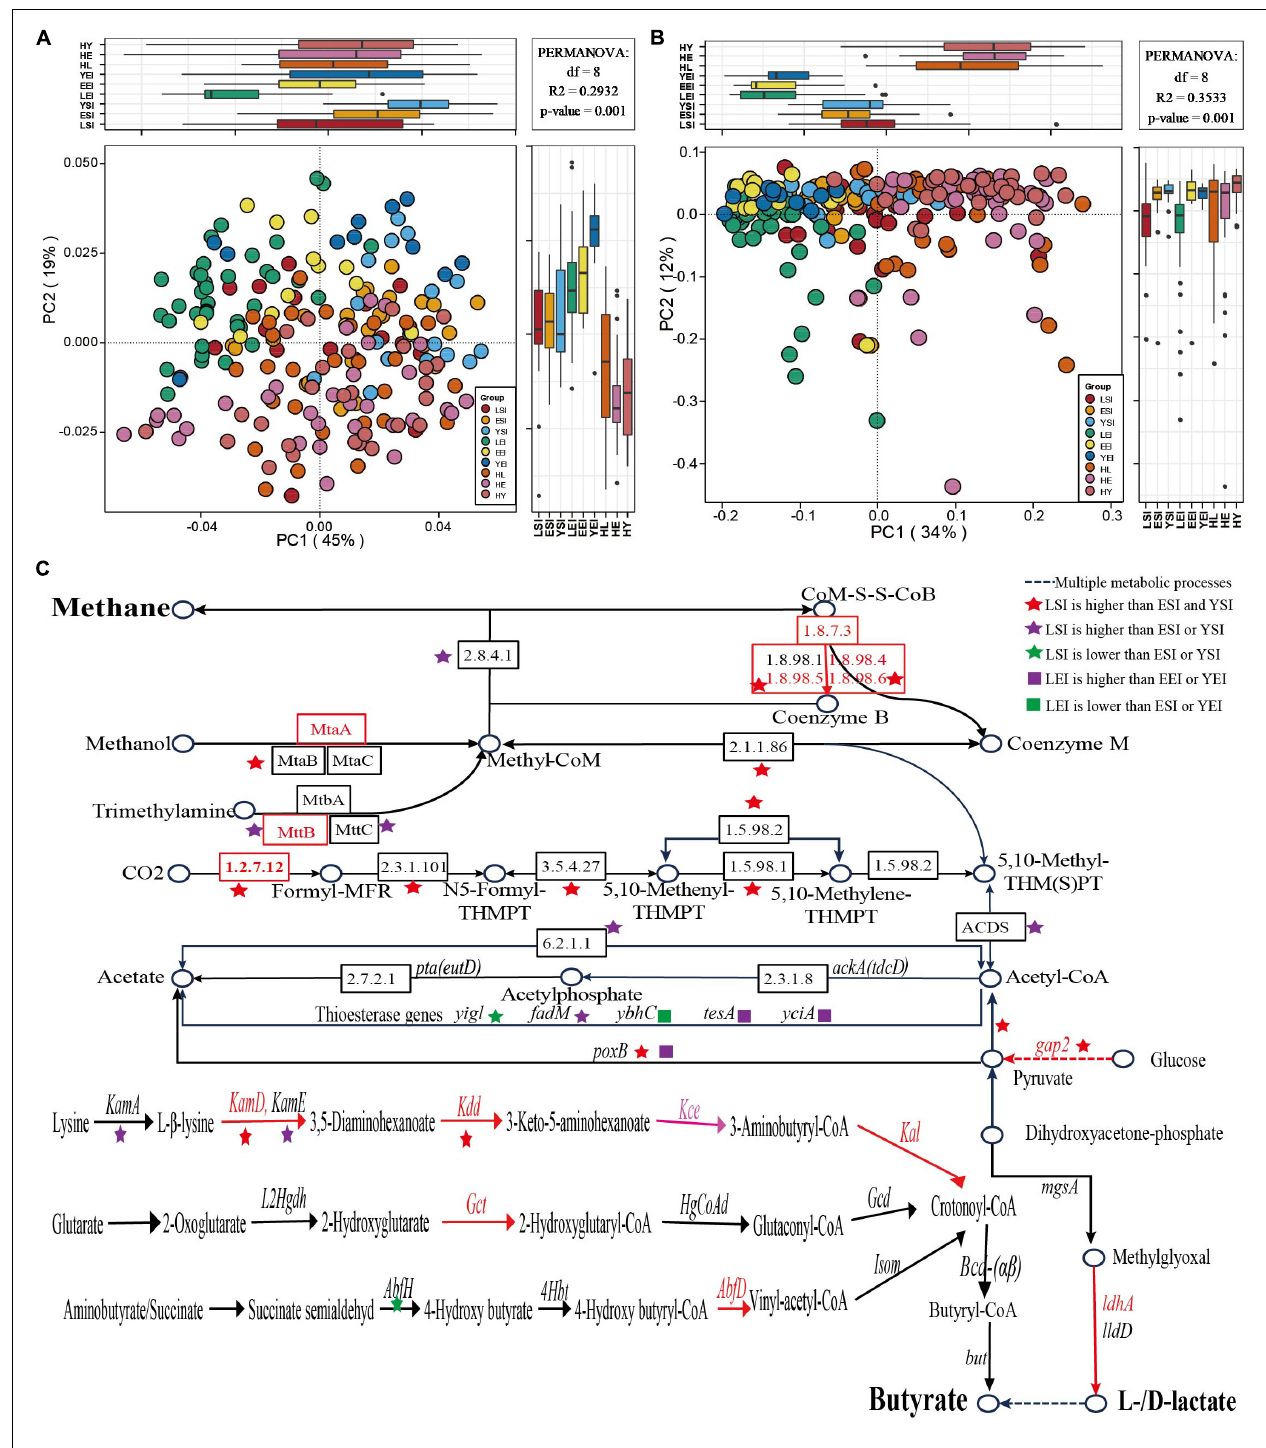
FIGURE 5 | Gut microbiota signatures of healthy aging in different regions. (A,B) principal-coordinate analysis (PCoA) based on the Bray-Curtis distance derived from the relative abundance of the species (A) and KEGG orthologous (KOs) (B) were plotted for the gut microbiota composition and function at the species and KOs level. (C) Differences of KOs in the methanogenesis and acetate, butyrate, and lactate biosynthesis pathways. HL, Chinese long-living group; HE, Chinese elderly group; HY, Chinese young group; LSI, Sardinia (Italian) long-living group; ESI, Sardinia (Italian) elderly group; YSI, Sardinia (Italian) young group; LEI, Emilia Romagna (Italian) elderly group; EEI, Emilia Romagna (Italian); YEI, Emilia Romagna (Italian) young